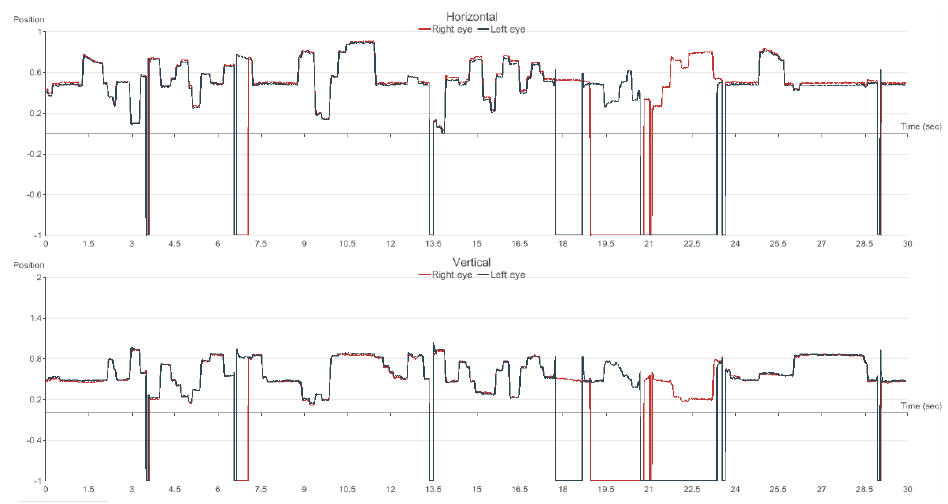
Figure 5. Eye movement graphs for horizontal and vertical eye movements.